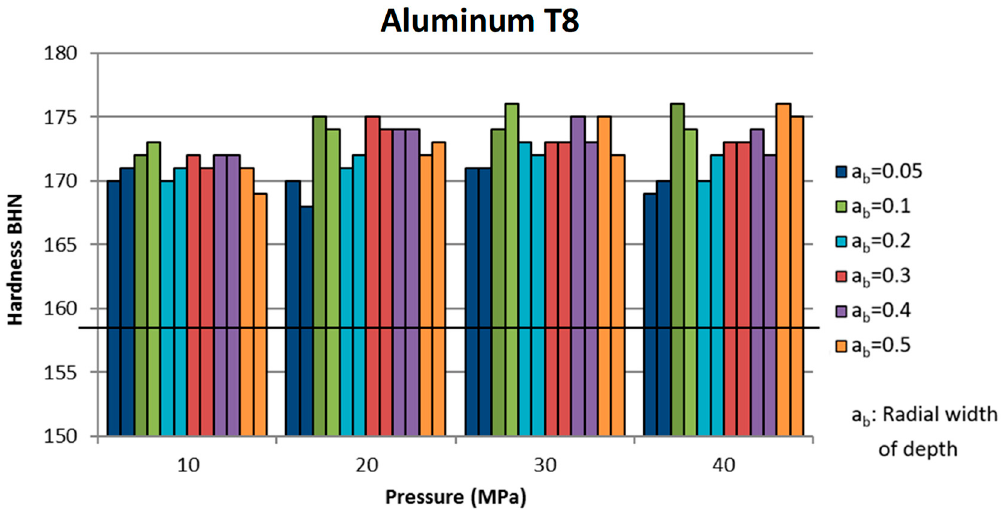
Figure 6. Effect of pressure, radial width, and number of passes in the surface hardness for the 2050 aluminum alloy with T8 heat treatment.